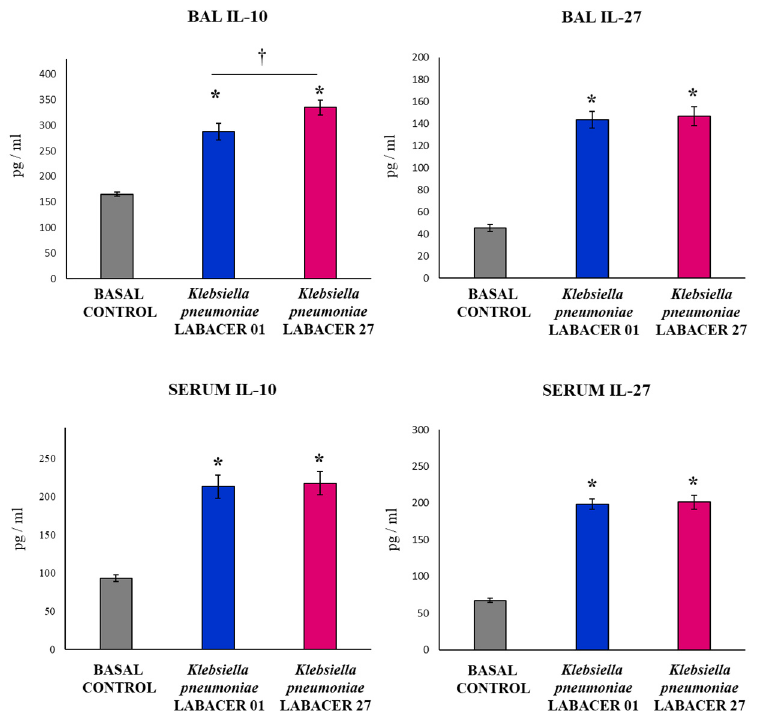
Figure 6. Variations in the regulatory cytokines in the respiratory tract and blood induced by KPC-2-producing hypermucoviscous ST25 strains of Klebsiella pneumoniae . Immunocompetent adult BALB/c mice (six weeks) were nasally challenged with K. pneumoniae LABACER 01 or LABACER 27. Two days after challenge, the IL-10 and IL-27 levels were determined in broncho-alveolar lavage (BAL) and blood samples. Results represent data from three independent experiments. Asterisks (*) indicate significant differences from the uninfected control group (basal control), p < 0.05. The crosses (†) indicate signi fi cant di ff erences between the indicated groups, p < 0.05.